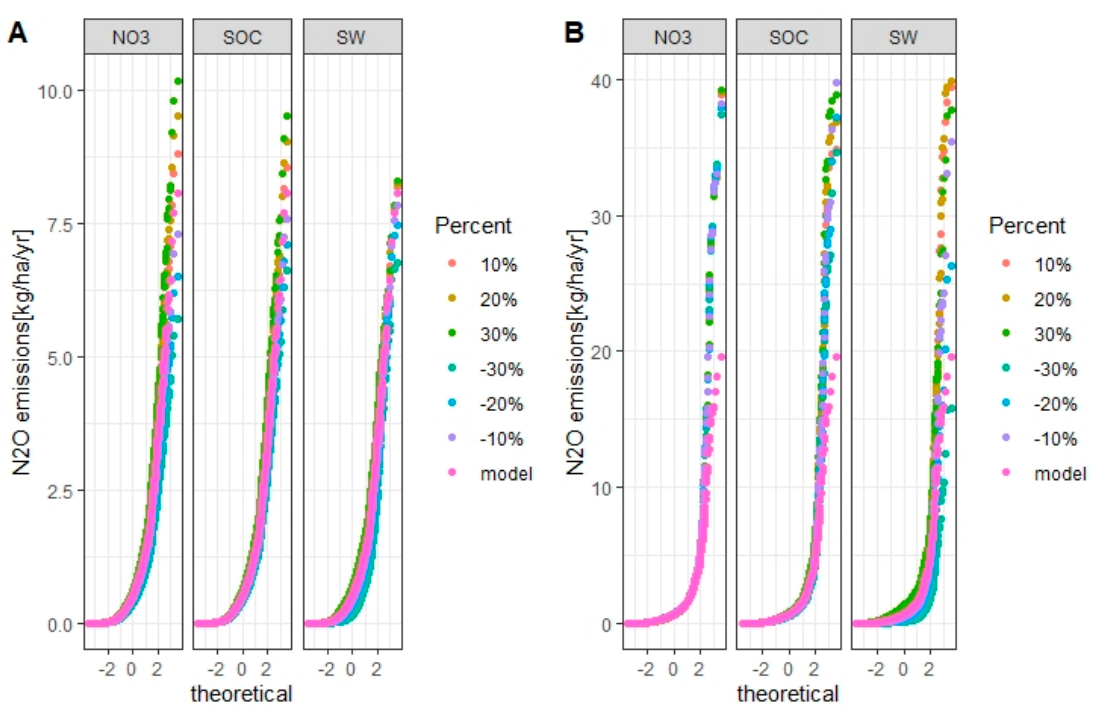
Figure 14. Uncertainties of simulated annual N 2 O emissions from winter wheat ( A ) and spring barley ( B ) in the Zaya catchment for each considered factor. The X-axis is the standard normal distribution of simulated N 2 O emissions with mean 0 and standard deviation 1. Model is the validated SWAT model and is the baseline.